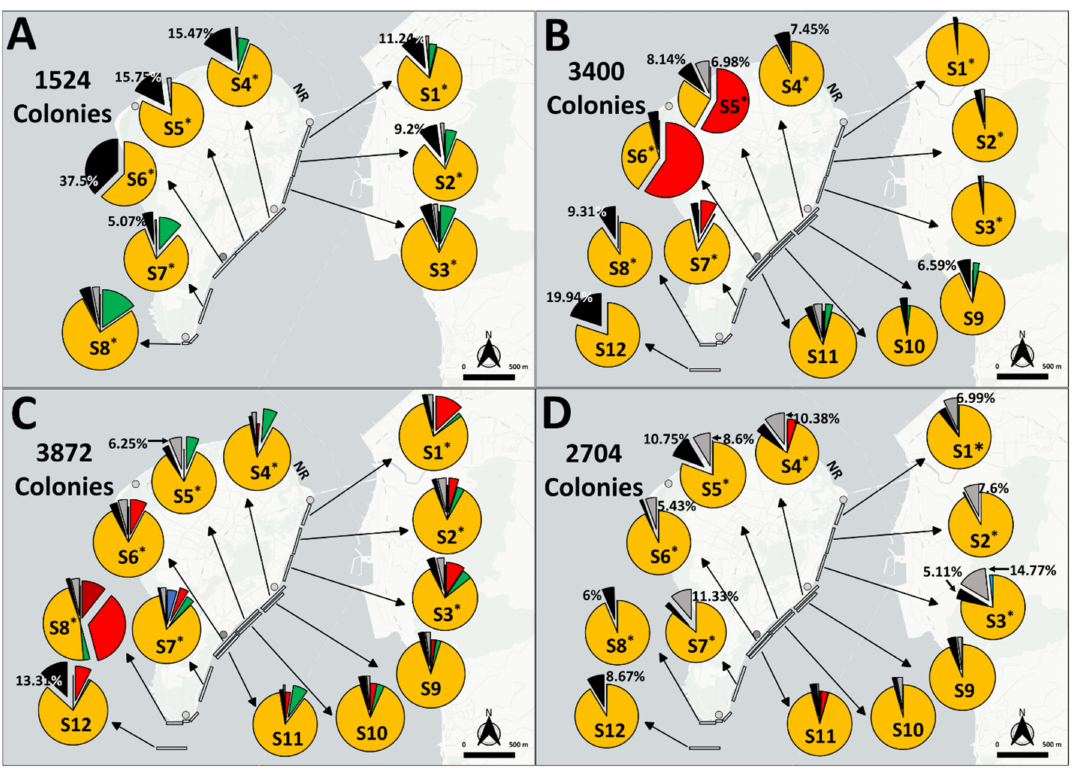
Figure 6. Prevalence of BBD (black) and GAs (grey) on encrusting Montipora spp. around Sesoko Island. Yellow: healthy Montipora colonies, red: heavily bleached or seriously damaged colonies, maroon: dead colonies; green: pale and/or slightly damaged; * NS sites ( A ) 2017 ( B ) 2018 ( C ) 2019 ( D ) 2020. Only >5% outbreak prevalence [66] for BBD and GAs are